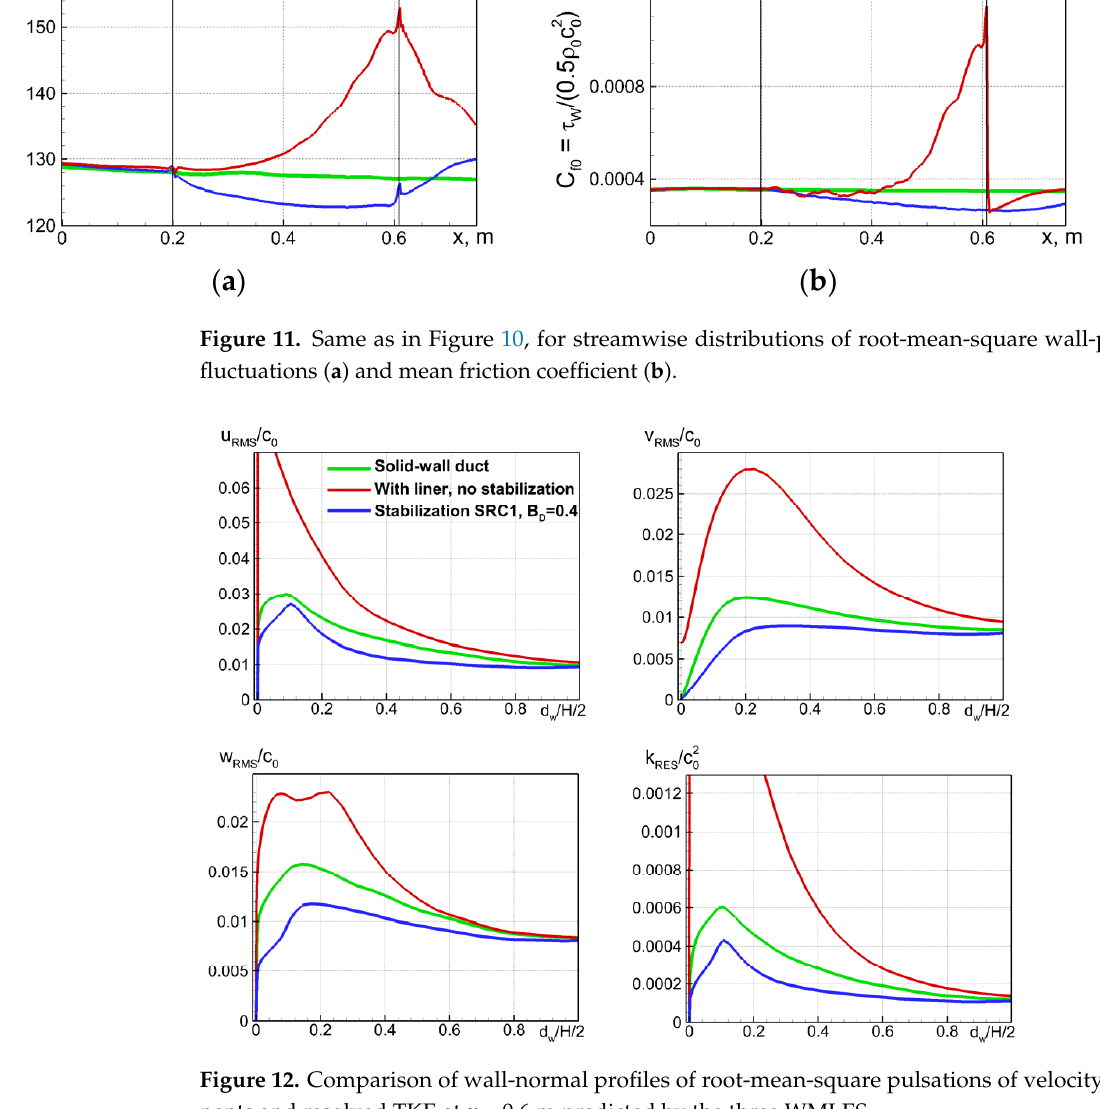
Figure 10. Comparison of wall-pressure spectra at x = 0.6 m predicted by WMLES of three flows. Green: duct with solid walls, original equations; red: duct with liner, original equations; blue: duct with liner, equations with added stabilization body force SRC1 (7) at B D = 0.4.